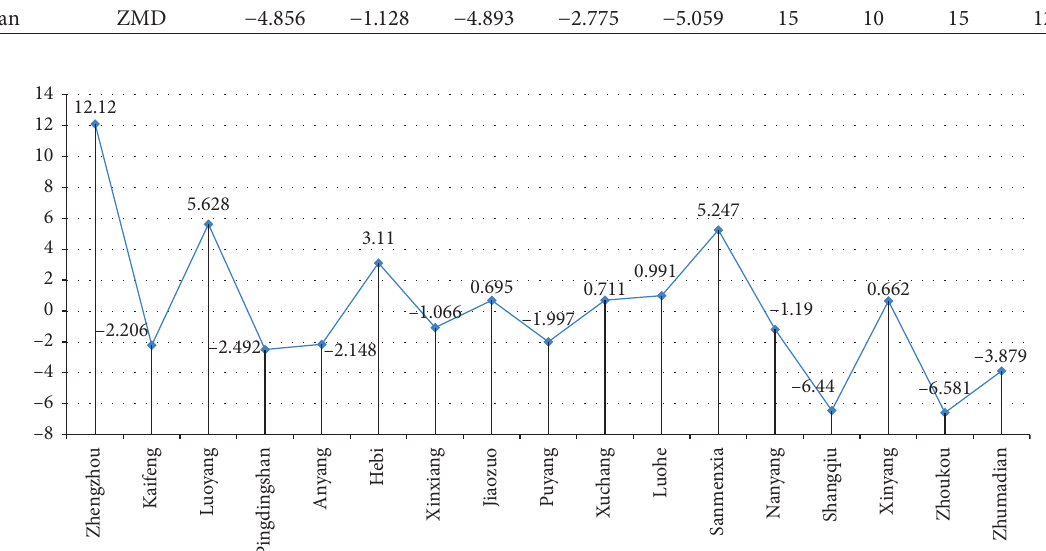
Jiaozuo Xuchang Nanyang